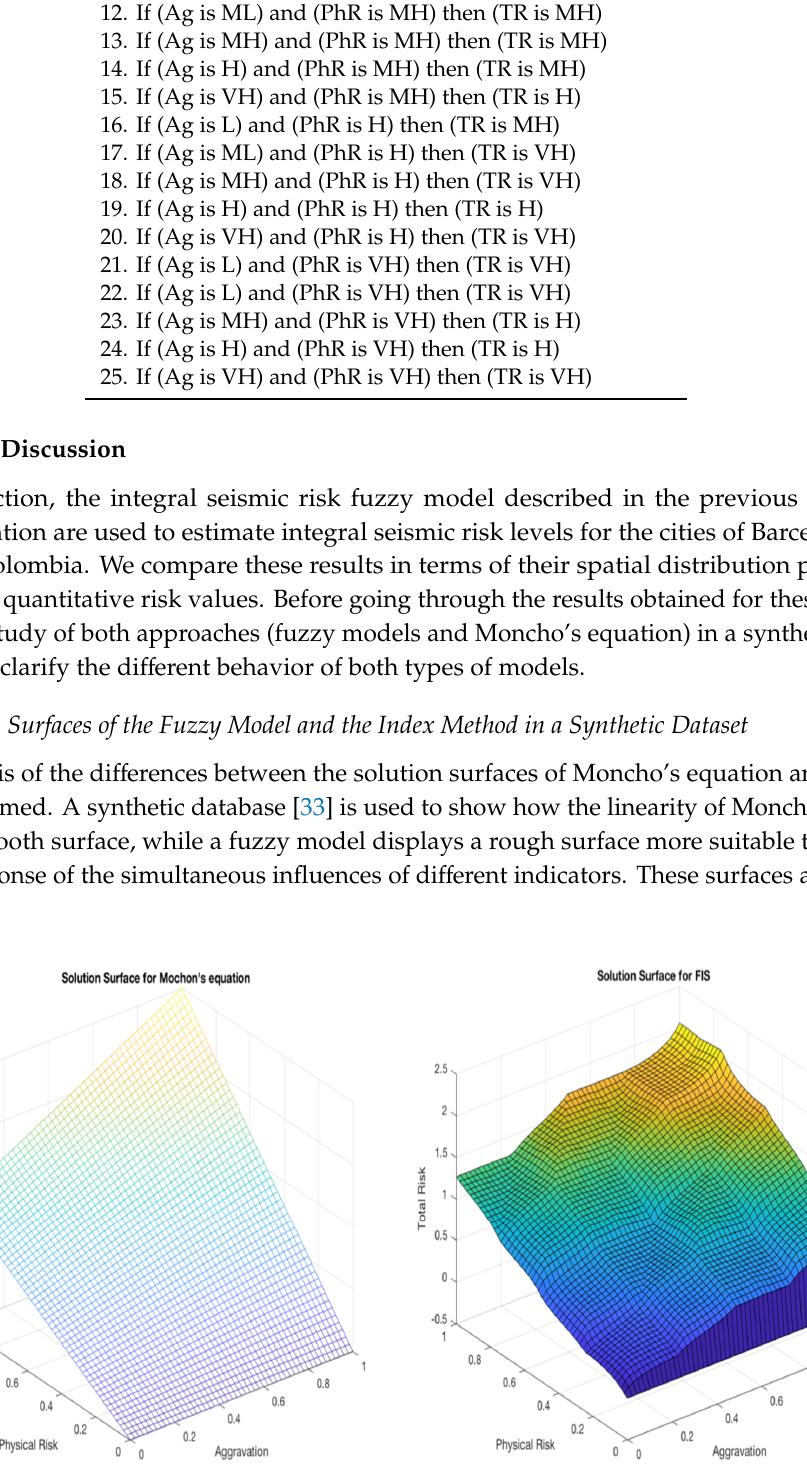
Figure 3. Moncho’s equation Surface ( left ) and Fuzzy Decision Surface ( right ) generated from a synthetic database of 100 numerical values ranging from 0 to 1 and taking finite steps of 0.02 units